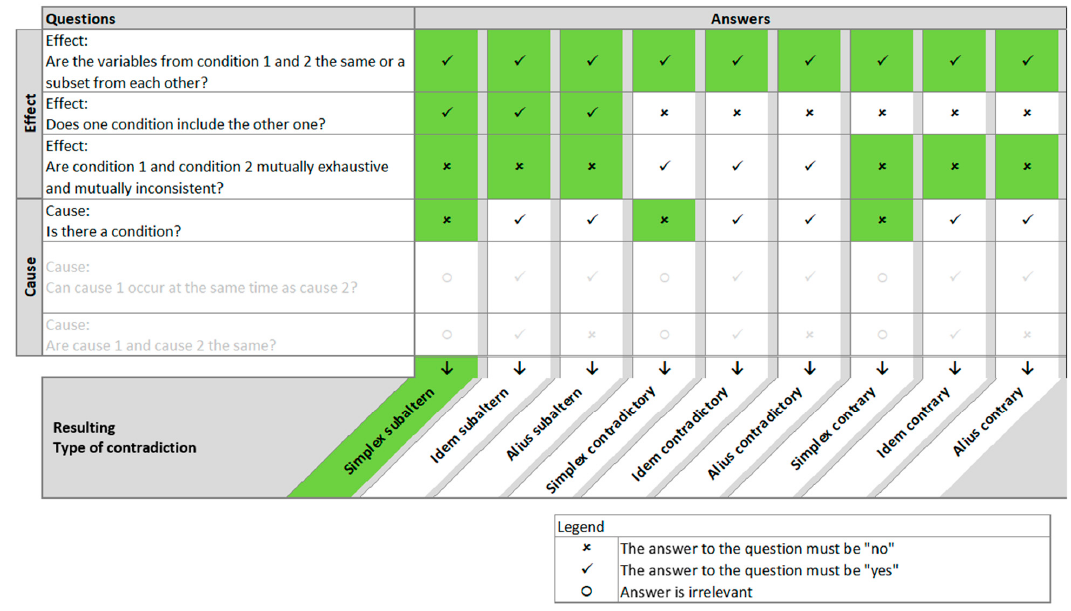
Figure 7. Process for Simplex Subaltern.